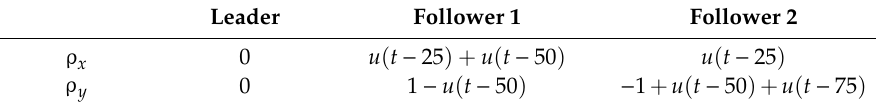
Table 13. The x and y reference states for changing Table 13. The (cid:1876) and (cid:1877) reference states for changing formation.